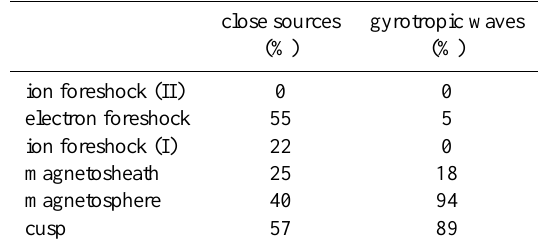
Table 1. The average number of close sources and the average num- ber of gyrotropic samples for each magnetospheric